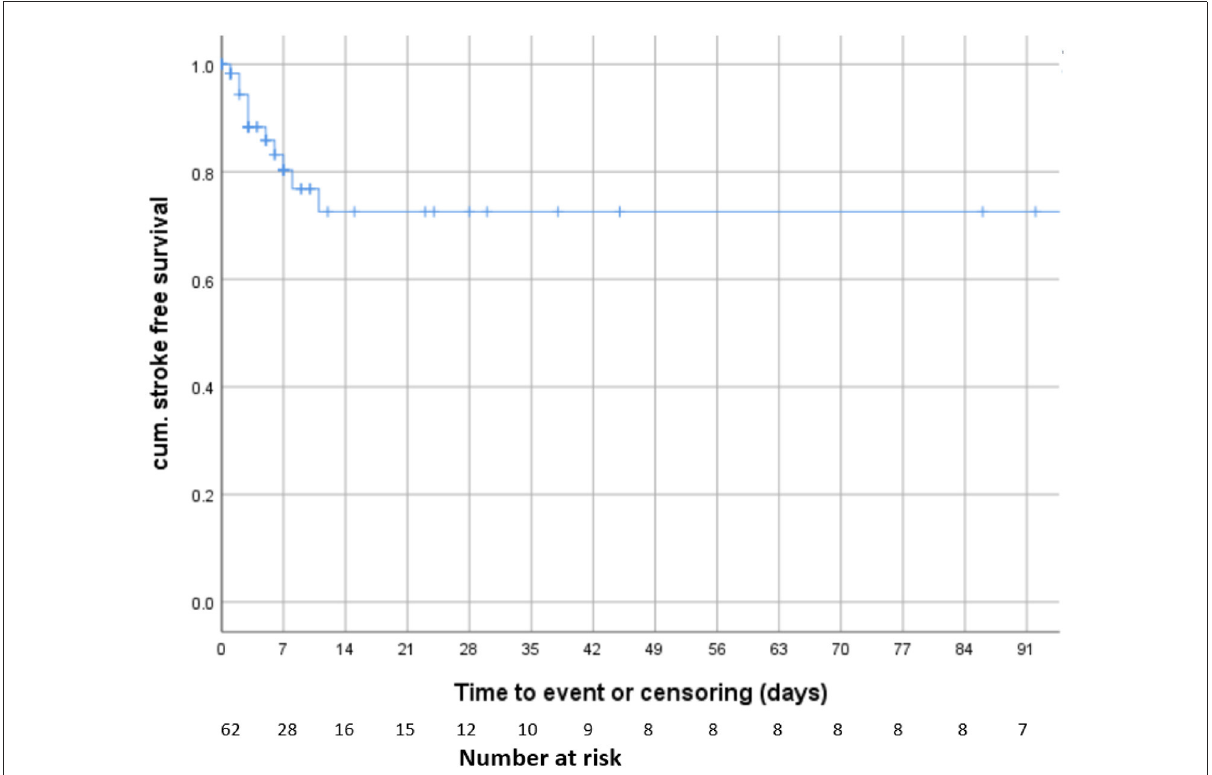
FIGURE2 Survival analysis. Kaplan-Meier model including all patients and censoring patients at the time of treatment or last